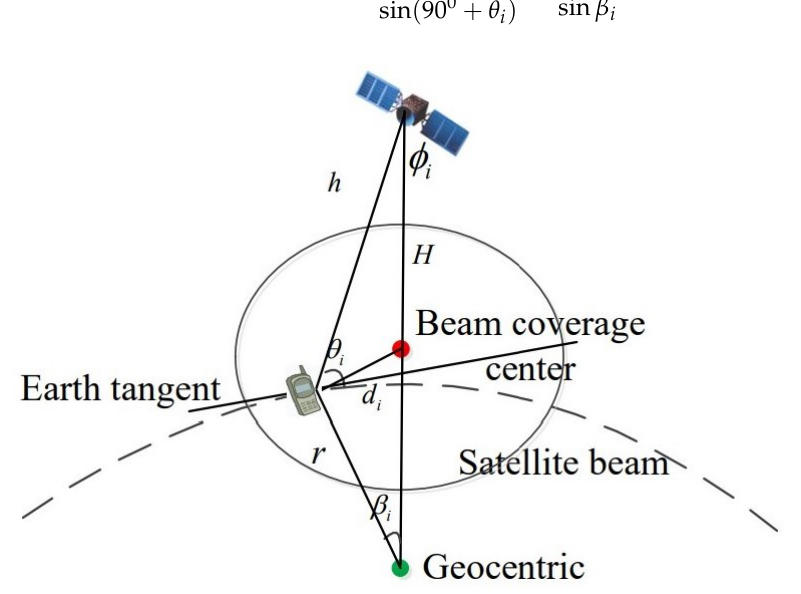
Figure 2. Geometric relationship of beam